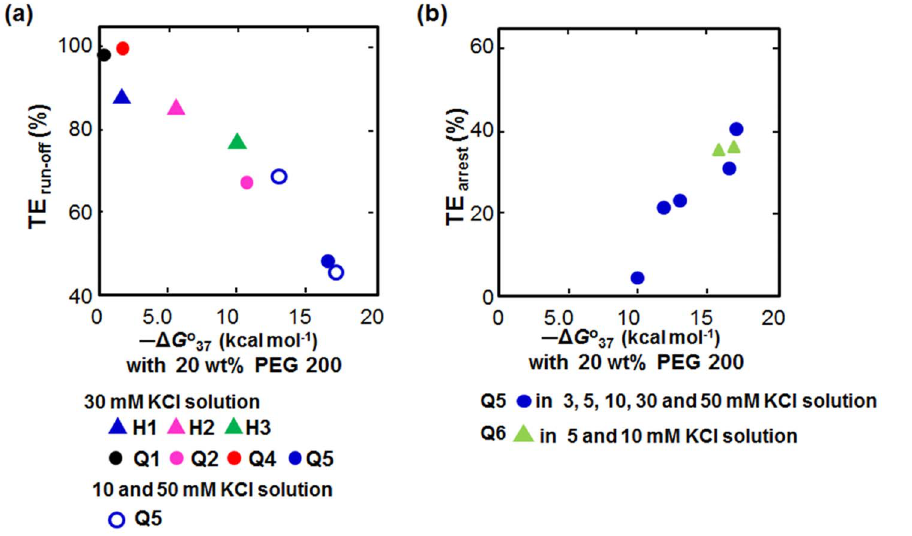
Figure 4. Correlation between 2 D G o 37 values obtained in 20 wt% PEG200 and transcription efficiency (TE). (a) TE of run-off transcripts and (b) TE of arrested transcript. Reaction mixtures contained 0.3 m M T7 polymerase and 1.5 m M DNA template in a buffer containing 40 mM Tris-HCl (pH 8.0), 8 mM MgCl 2 , and 2 mM spermidine, and reactions were incubated for 90 min at 37 u C.